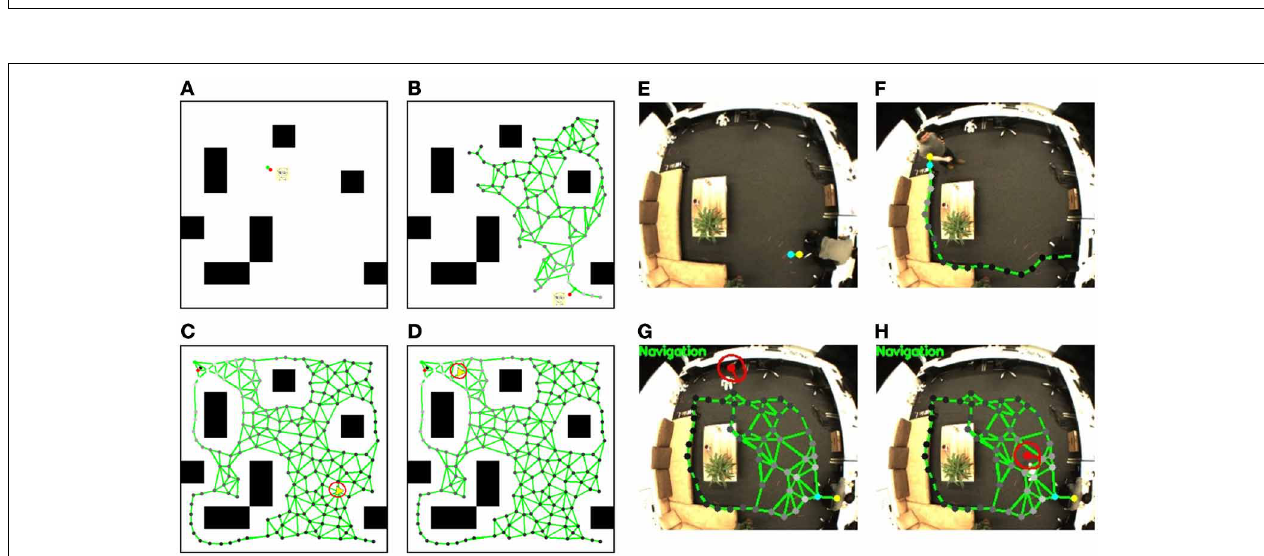
robot navigation toward the person’s position are implemented. (B) Real test environment: A room containing some furniture with a size of 7 m × 5 m . Several objects are placed on the tea table for testing feature anchoring.